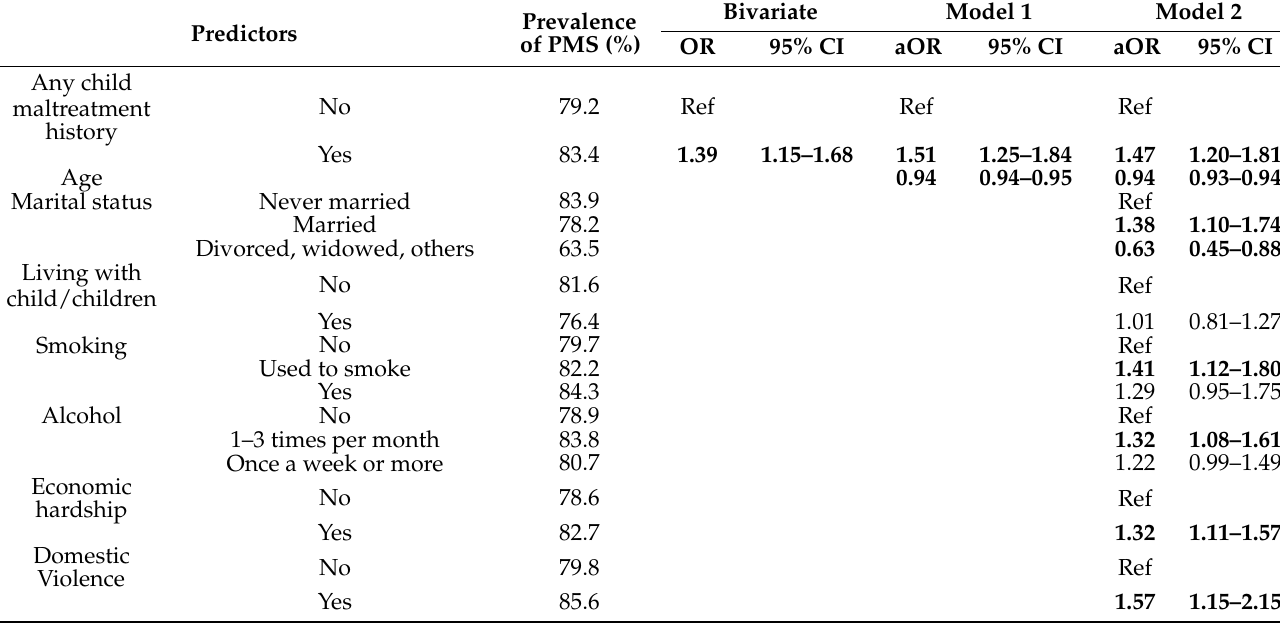
Table 2. Bivariate and multivariate associations between childhood maltreatment history and premenstrual